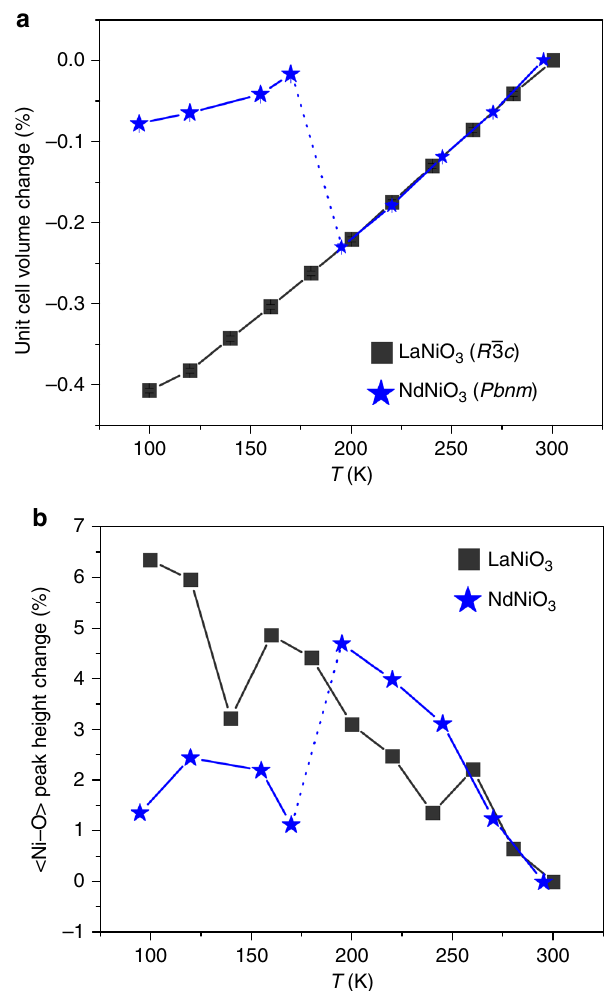
Fig. 2 Temperature dependence of the unit cell parameters. a The change in unit cell volume for NdNiO 3 (blue stars) and LaNiO 3 (black squares) determined by neutron diffraction as a function of temperature T . For continuity, NdNiO 3 was re fi ned using the orthorhombic ( Pbnm ) polymorph for the entire temperature range while LaNiO 3 was re fi ned using the rhombohedral ( R 3 c ) polymorph. b The peak height of the nearest-neighbor Ni – O correlation in the PDF of NdNiO 3 (blue stars) and LaNiO 3 (black squares). The error bars in both panels are smaller than the size of the data markers and were determined from uncertainty in the unit cell volume as determined through Rietveld re fi nement in GSAS, which were then normalized to the unit cell volume at room